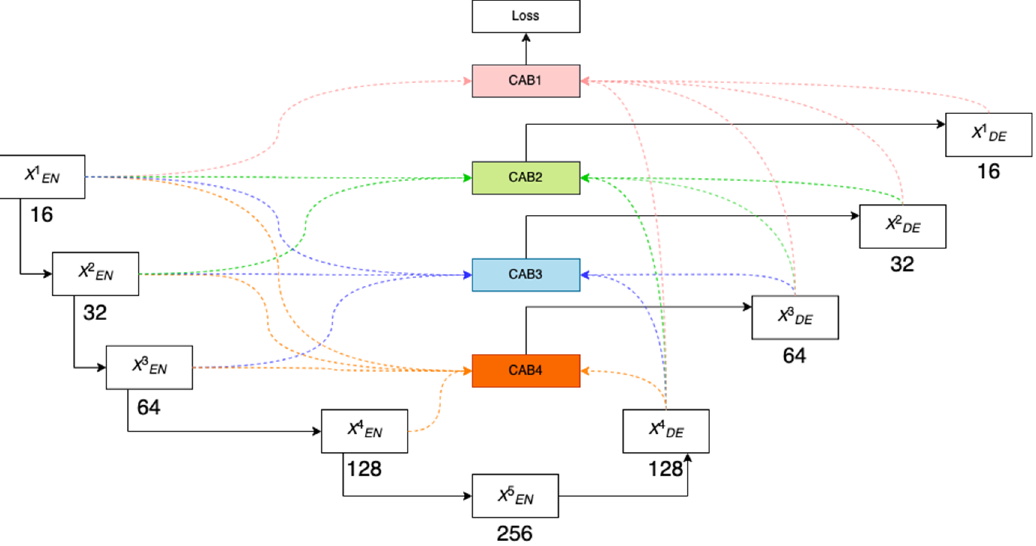
Figure 5. MACU network diagram with multi-scale connectors (adapted from [14]). The CAB represents channel attention blocks. Colored dotted arrows represent the multi-scale skip connectors to each CAB.